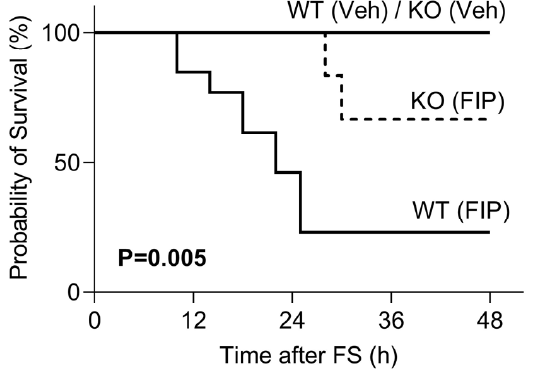
Figure 1. OSMR type II receptor knockout (KO) confers a survival advantage compared to wild-type (WT) mice subjected to fecal slurry-induced peritonitis (FIP). Kaplan–Meier curves depicting the survival of OSMR type II receptor knockout (KO) and FIP mice that received an intraperitoneal injection of 1.3 mg/g of fecal slurry (FS). WT Veh (n = 3); KO Veh (n = 3); WT FIP (n = 14); KO FIP (n = 6). p = 0.005 via log-rank (Mantel-Cox) test.